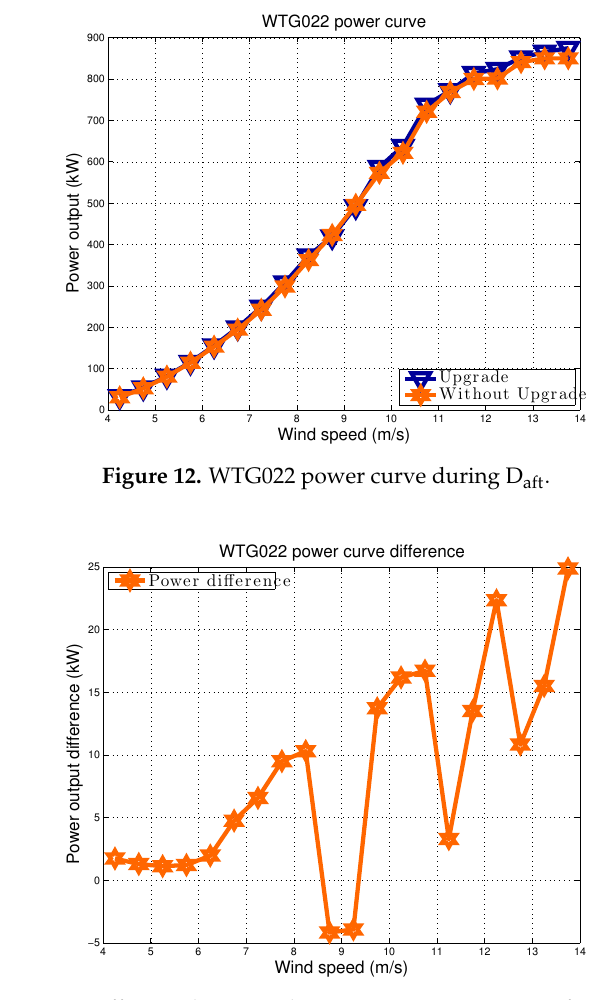
Figure 13. Difference between the WTG022 power curves of Figure